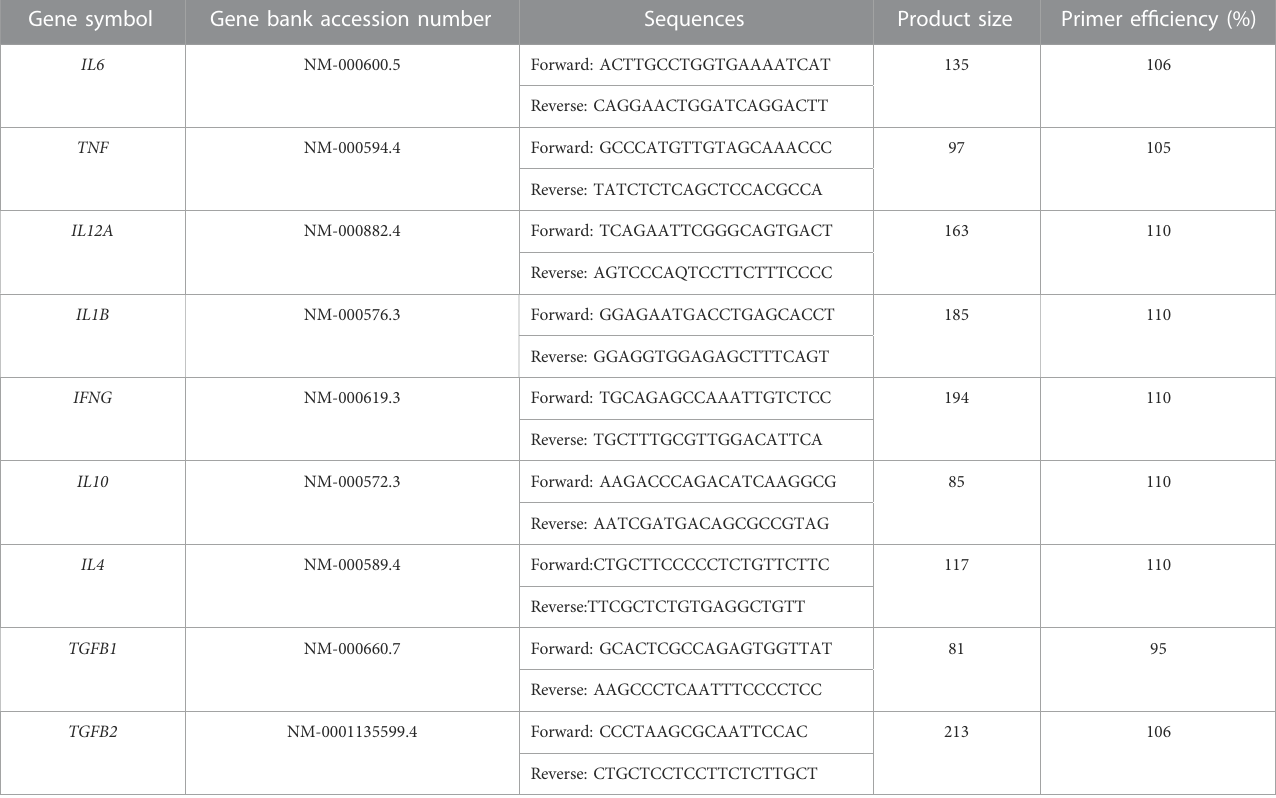
TABLE 1 Cytokine RNA sequences. Gene